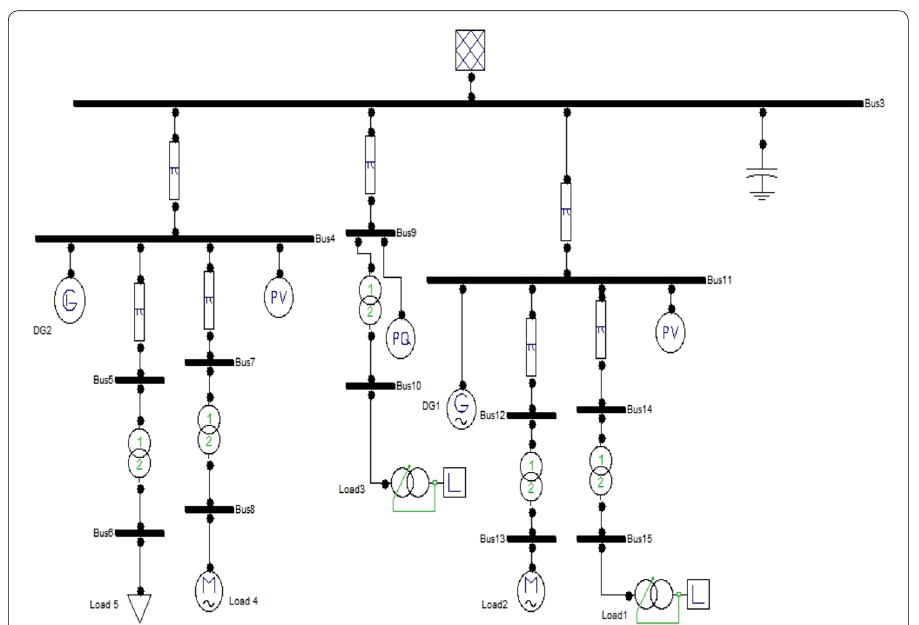
Fig. 4 Simulation model of the study